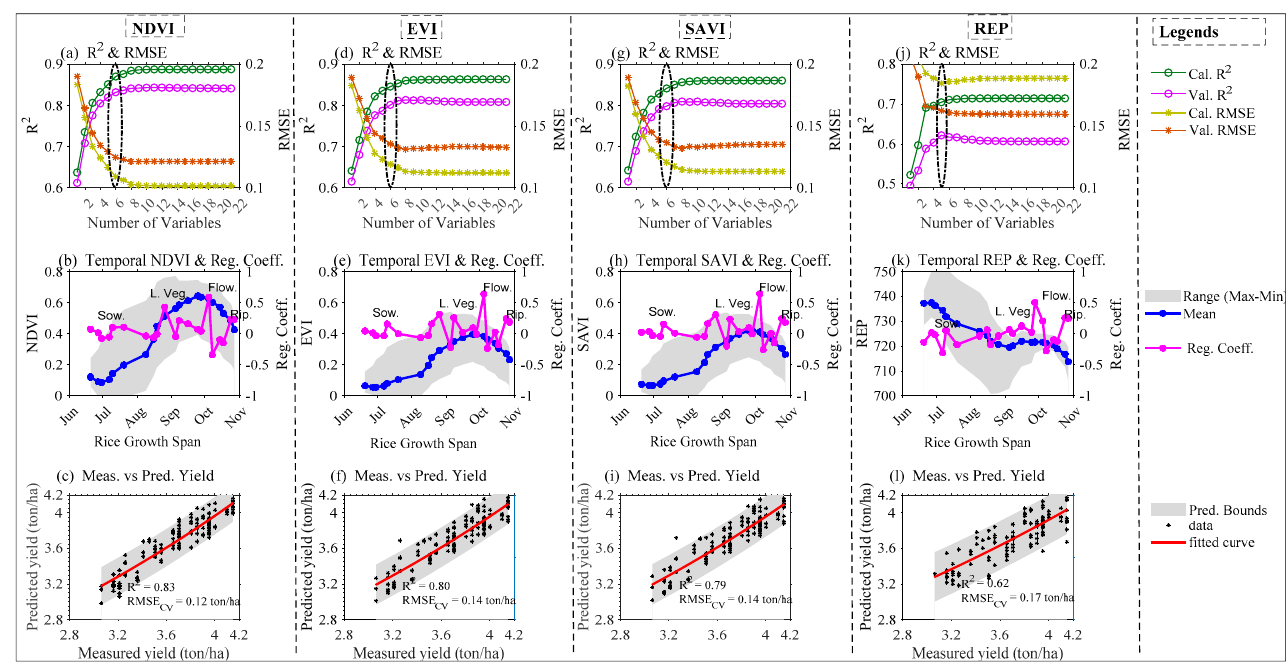
Figure 6. The analysis based on temporal NDVI, EVI, SAVI, and REP. The R 2 increases and RMSE decreases with augmenting the number of variables unless it reaches saturation (dashed elliptical in Panels a , d , g , j ). After certain number of latent variables, the decrease in RMSE was negligible and that was taken as the optimum number of variables for PLSR model development. The temporal profiles of vegetation indices are similar in shape except REP (Panels b , e , h , k ). The regression coefficients lines show that sowing, late vegetative, flowering and ripening are important phases for predicting rice yields using PLSR. The measured vs. predicted (Panels c , f , i , l ) manifest that yield was best predicted using temporal NDVI data (yielded highest R 2 and lowest RMSE).